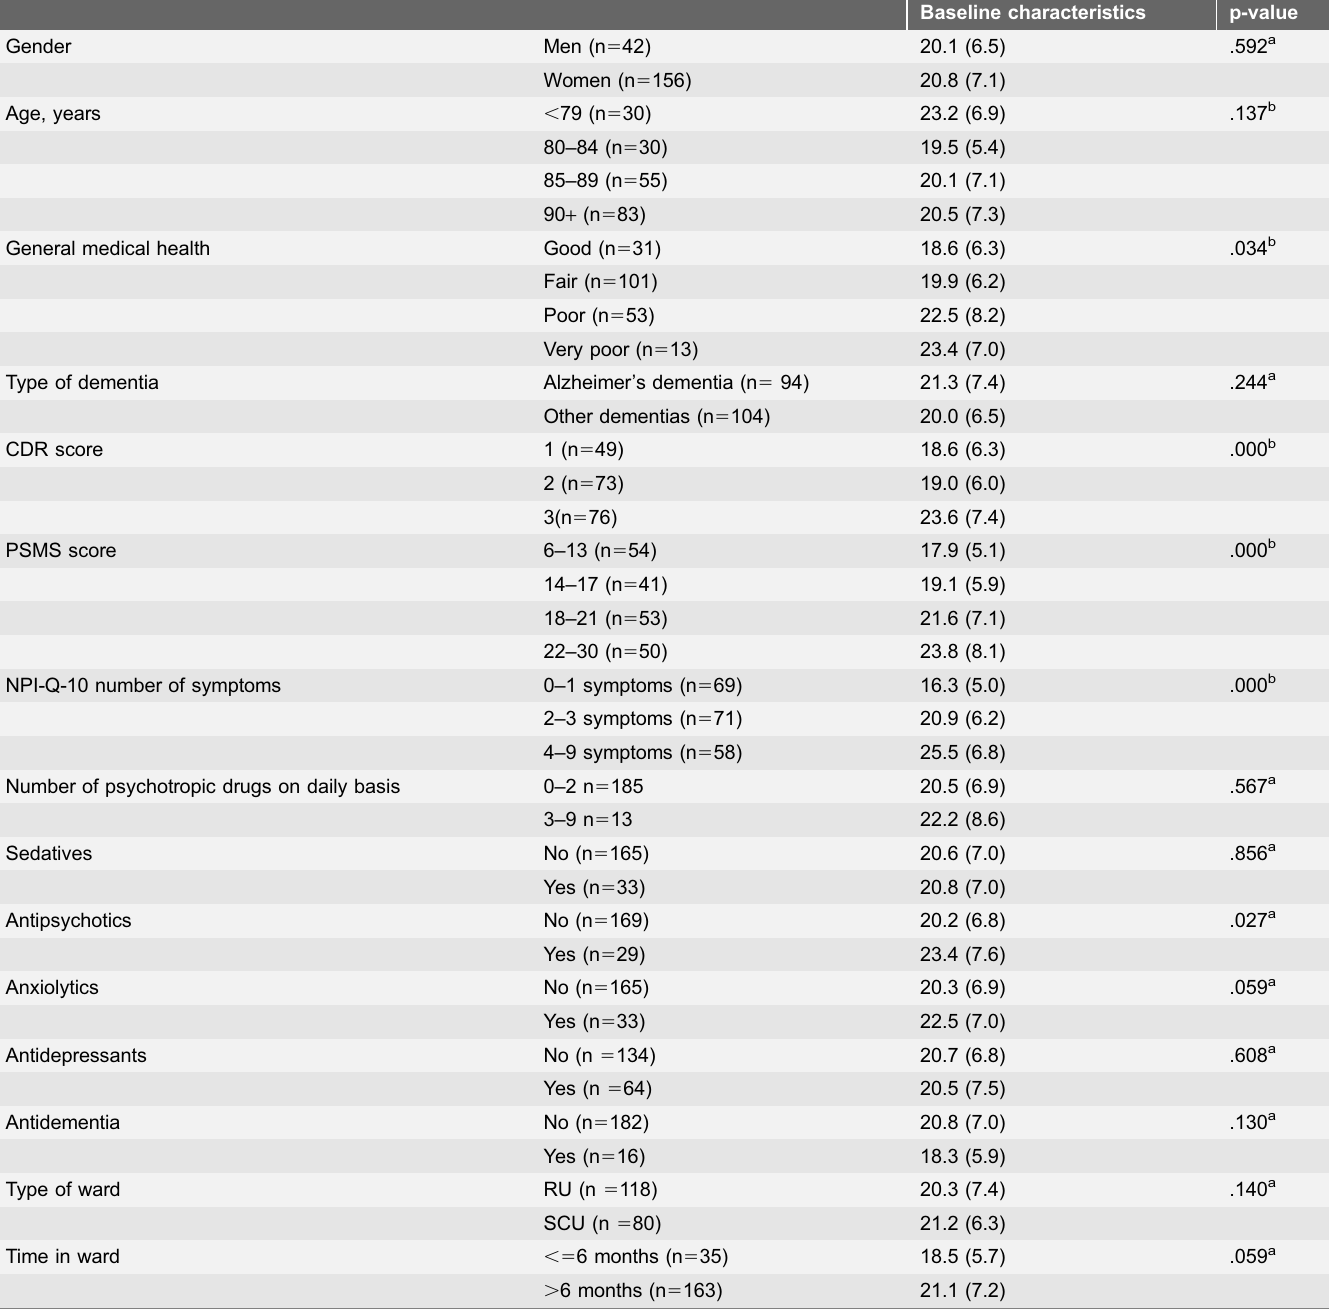
Table 1. Baseline characteristics of the 198 patients and QUALID scores of various subgroups of the